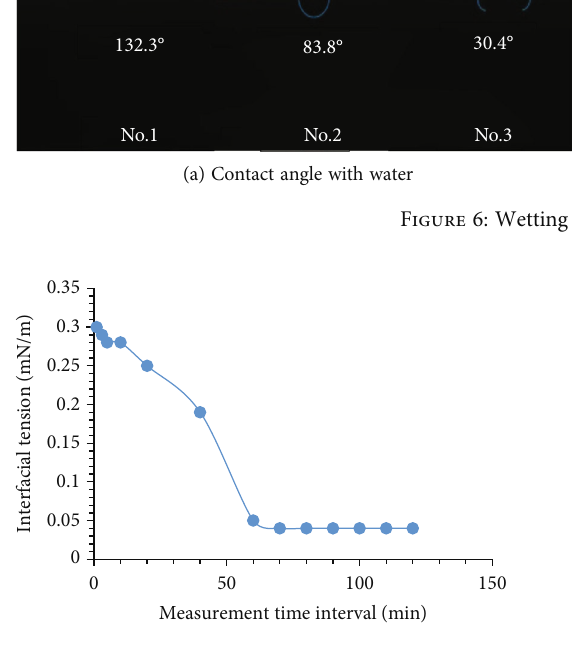
Figure 7: Change curve of interfacial tension between surfactant and crude oil with measurement time.